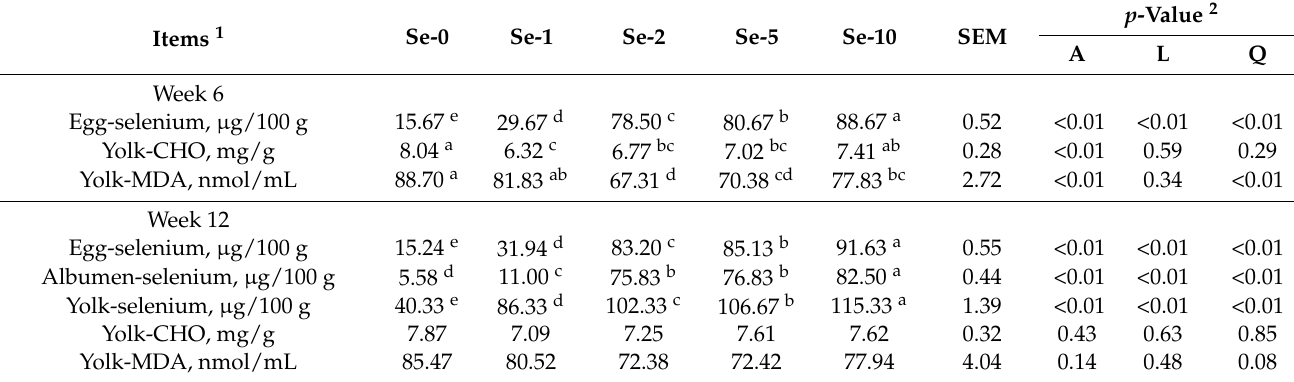
Table 5. Effects of dietary organic selenium on the concentration of selenium, cholesterol, and malondialdehyde of eggs in laying